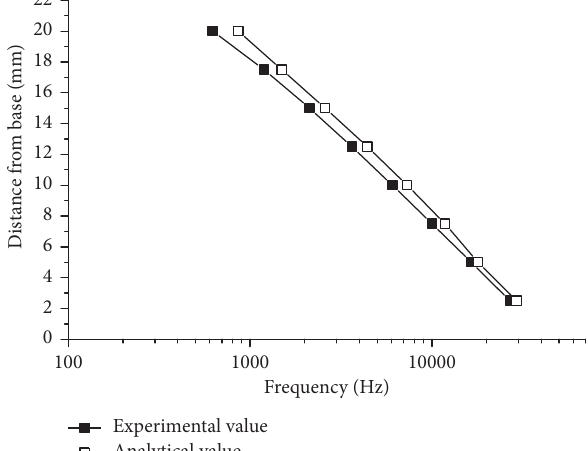
Figure 3: Frequency-position relationship of BM.